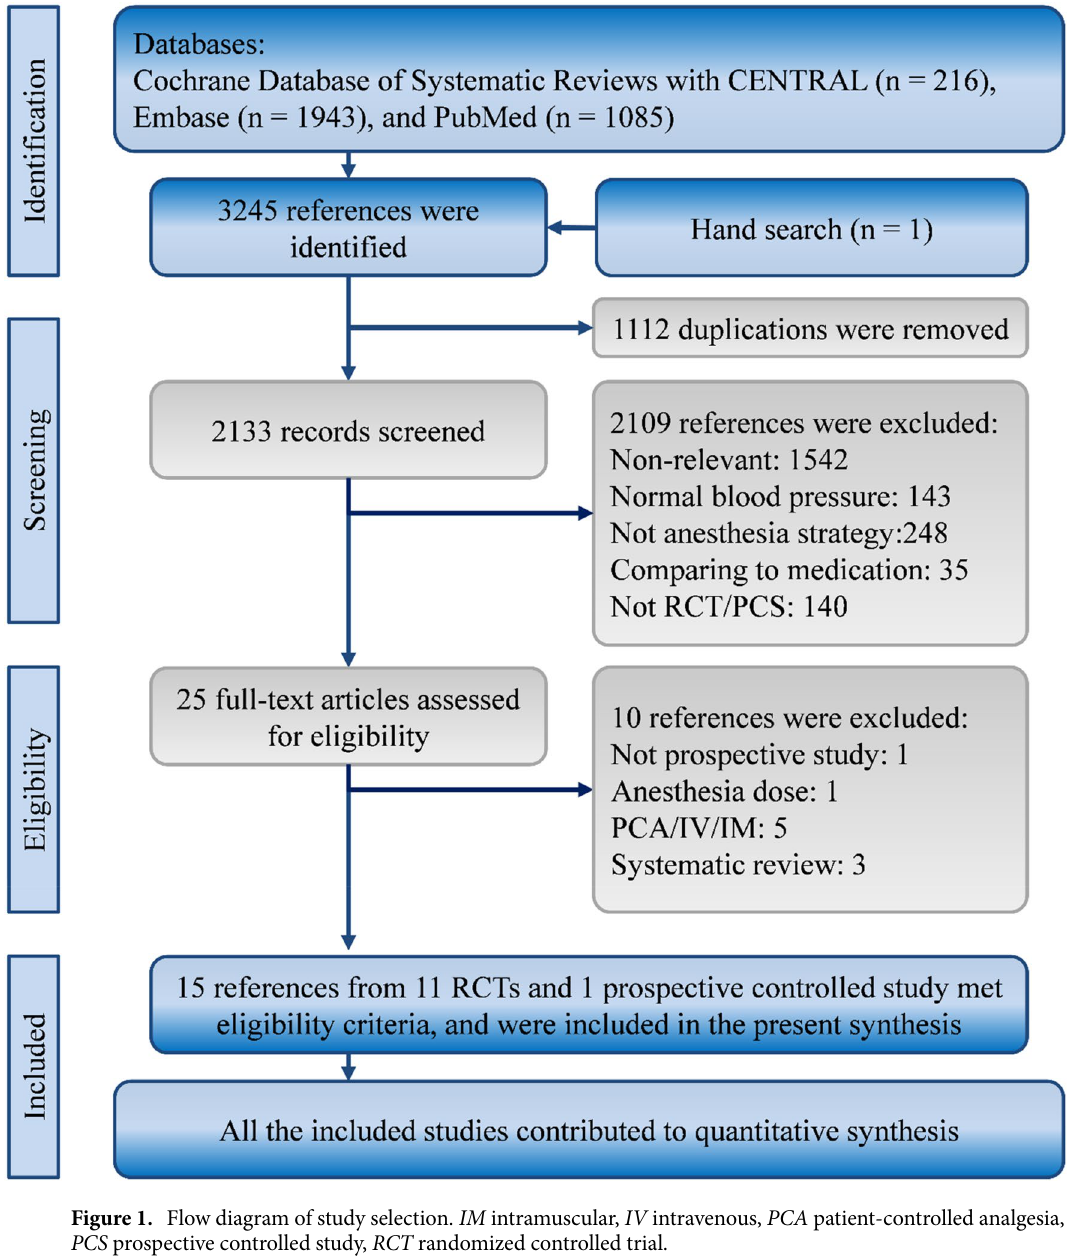
Figure 1. Flow diagram of study selection. IM intramuscular, IV intravenous, PCA patient-controlled analgesia, PCS prospective controlled study, RCT randomized controlled